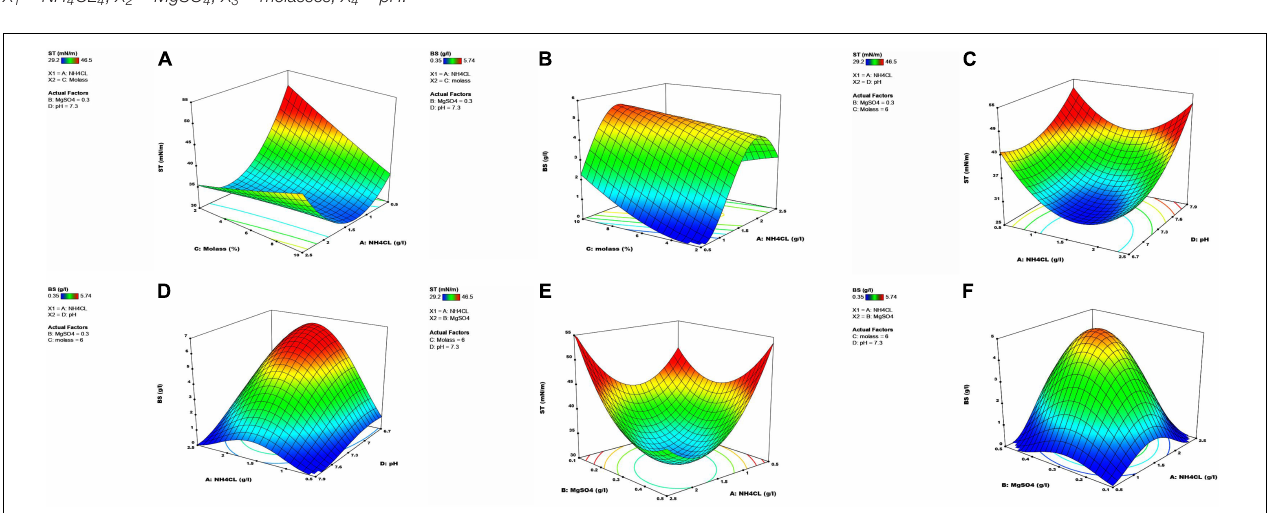
FIGURE 5 | Three-dimensional graphs showing the interactive effects of two independent factors on response variables, while in each graph, the third and fourth variables are set at its center point. (A) ST as a function of NH 4 CL and molasses, (B) BS as a function of NH 4 CL and molasses, (C) ST as a function of pH and NH 4 CL, (D) BS as a function of pH and NH 4 CL, (E) ST as a function of MgSO 4 and NH 4 CL, (F) BS as a function of MgSO 4 and NH 4 CL.